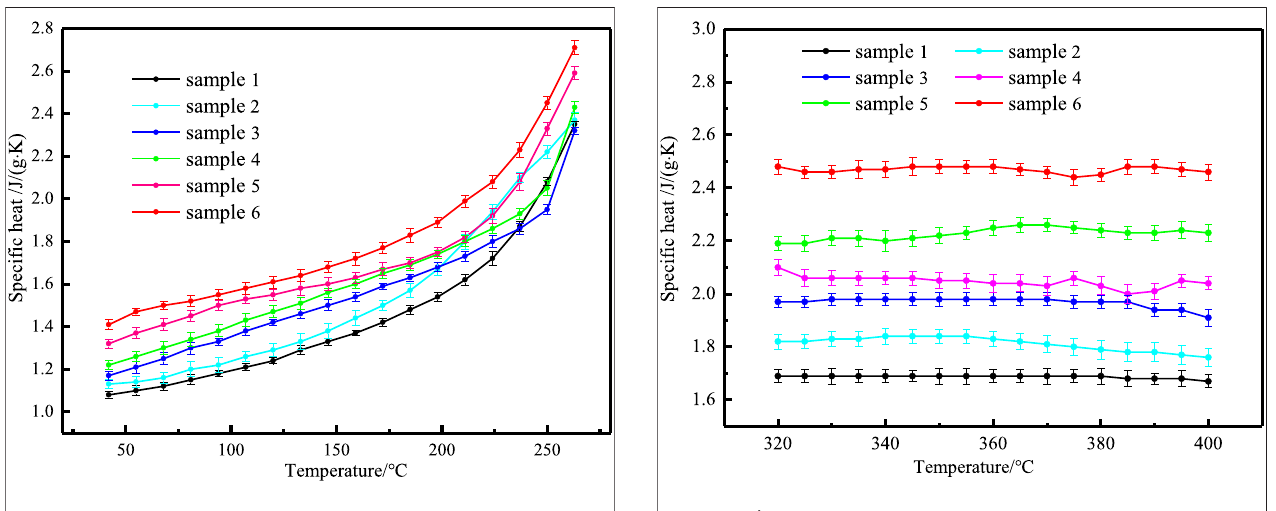
FIGURE 7 | Speci fi c heat before phase change ofdifferent samples vary temperature.